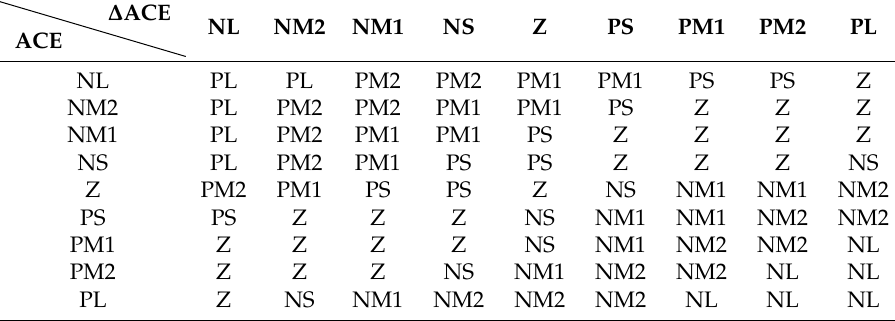
Table 2. Fuzzy control rules. NL, negative large; NM, negative medium; NS, negative small; Z, zero; PS, positive small; PM, positive medium; PL, positive large.